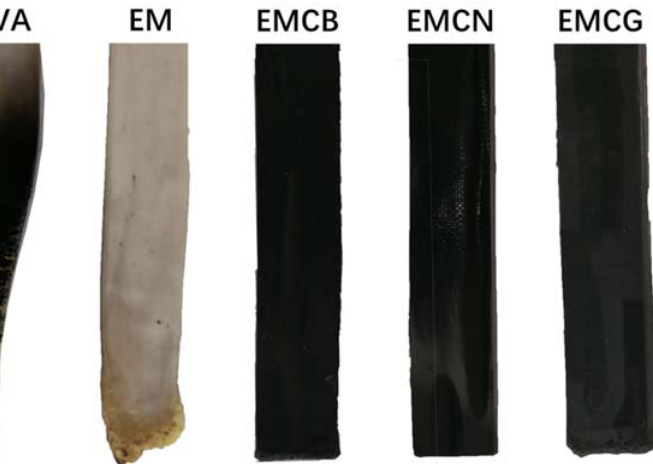
Figure 3. Digital photos of EVA composites after UL-94 tests.